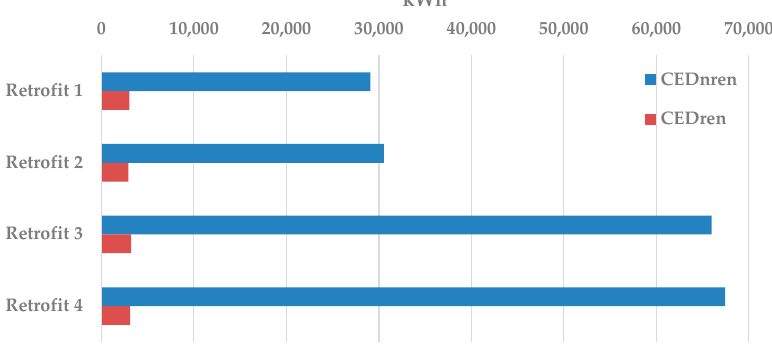
Figure 5. Cumulative energy demand (CED) for the various retrofits, i.e., renewable (CED ren ) and non ‐ renewable (CED nren ) values.